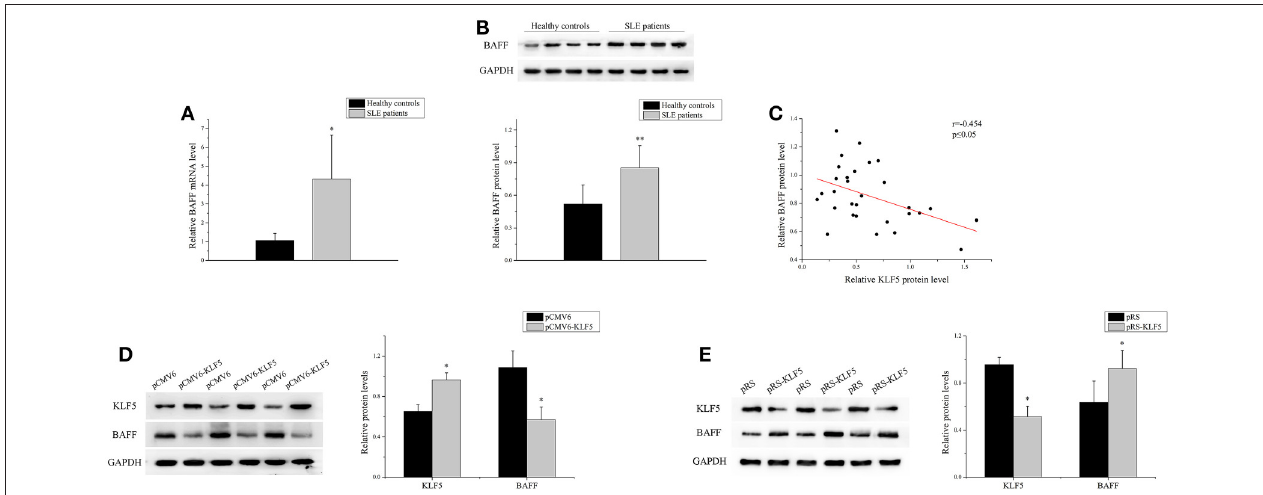
FIGURE 4 | KLF5 regulated BAFF expression in B-cells. (A) The relative BAFF level in B-cells isolated from healthy controls or patients with SLE ( n = 30 for each group) was assessed by real-time PCR and normalized to GAPDH. The variables were compared using the Student t -test. (B) The BAFF protein expression in B-cells isolated from healthy controls or patients with SLE ( n = 30 for each group) was analyzed by western blot analysis. One representative blot is shown (upper panel). The intensity of bands was semi-quantitated and normalized to GAPDH (lower panel). The variables were compared using the Student t -test. (C) The correlation between KLF5 and BAFF protein levels in SLE B-cells ( n = 30). (D) The KLF5 and BAFF protein levels in SLE B-cells after transfection with pCMV6 or pCMV6-KLF5. All experiments were performed in triplicate. One representative blot is shown (left panel). The intensity of bands was semi-quantitated and normalized to GAPDH (right panel). The variables were compared using the paired t -test. (E) The KLF5 and BAFF protein levels in B-cells of healthy controls after transfection with pRS or pRS-KLF5. All experiments were performed in triplicate. One representative blot is shown (left panel). The intensity of the bands was semi-quantitated and normalized